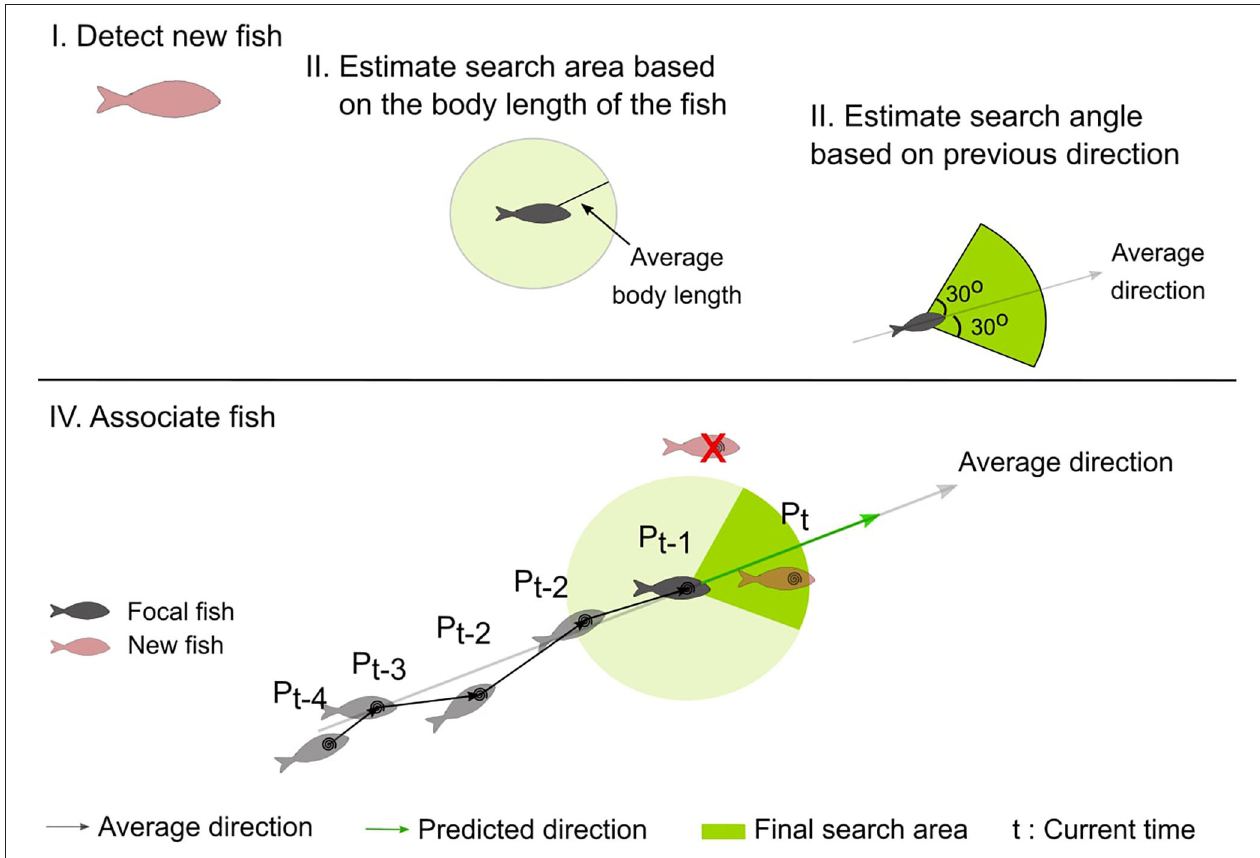
FIGURE 4 | Schematic representation of the steps followed to estimate the search area (shown as a circular sector shaded in green), and to associate the fish (see text for details). (I) the fish of the current frame are detected (new fish), (II) the maximum distance the focal fish has traveled is calculated based on the body-length of the fish, (III) the direction the focal fish has moved is calculated based on the heading directions of the previous frames, (IV) The focal fish is associated with a newly detected fish that is located within the search